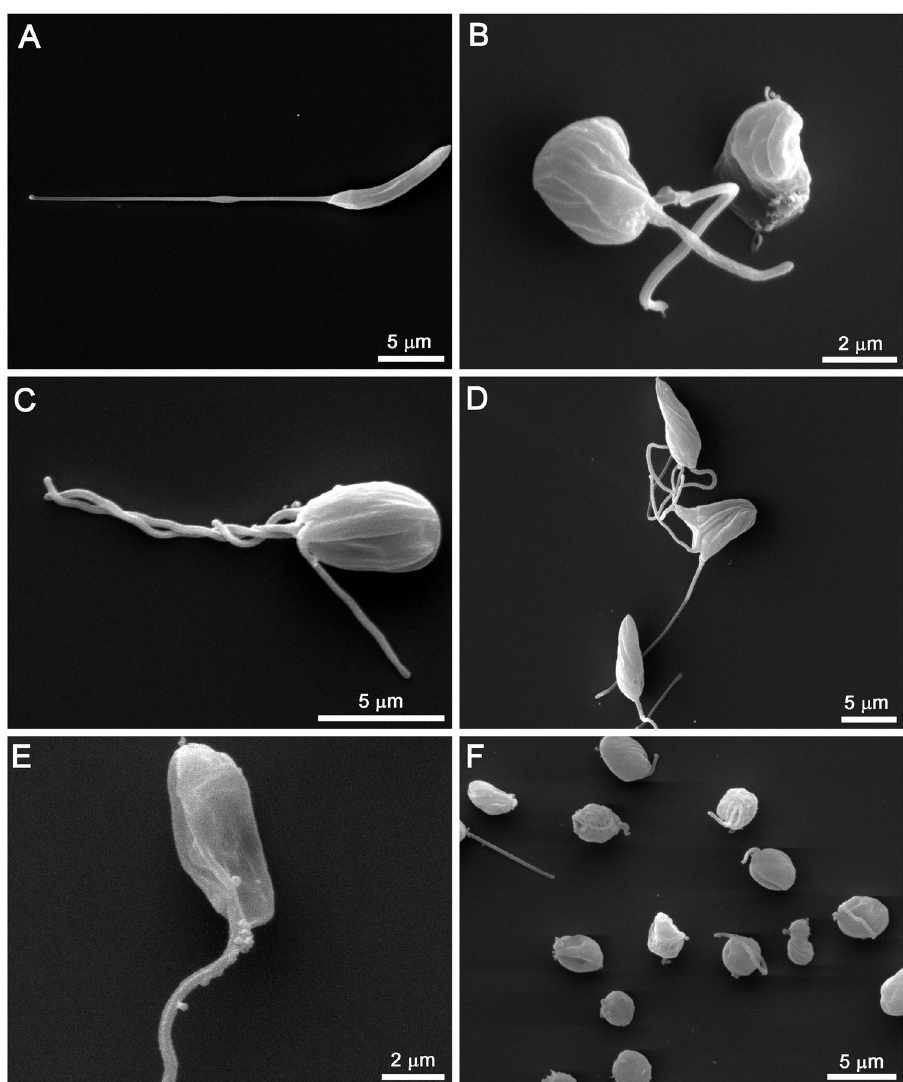
Figure 6. Scanning electron microscopy (SEM) of L. amazonensis promastigotes treated with SBCs for 48 h. ( A ) Control. ( B , C ) 500 nM SBC 39. ( D ) 1 µM SBC 39. ( E ) 100 nM SBC 40. ( F ) 300 nM SBC 40. The images show several changes in the morphology of the parasite. Promastigotes appeared rounded and swollen ( B , C , F ), with vesicles next to the flagellar pocket ( E ). Sometimes more than two flagella can be observed ( C , D